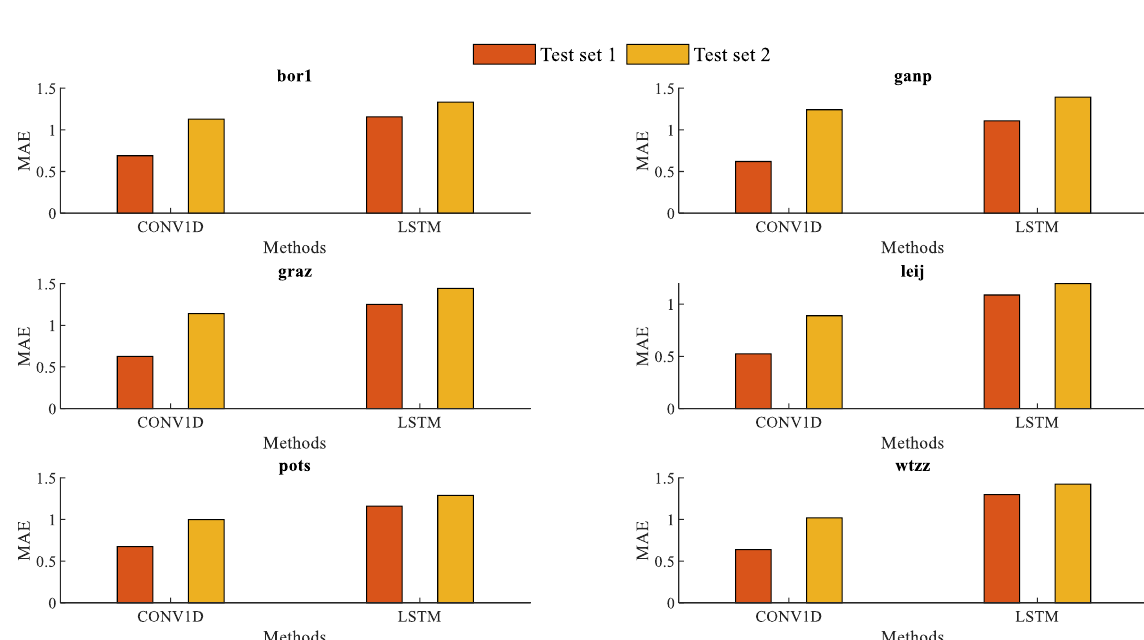
Figure 3. Conv1d versus ground truth per satellite